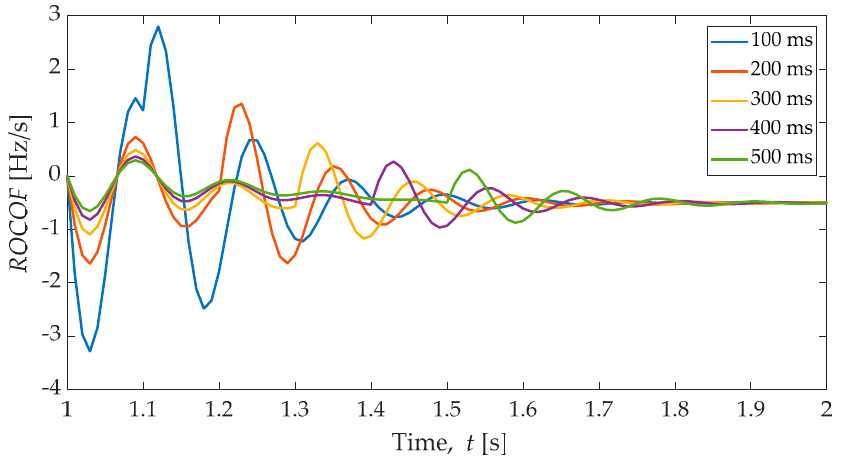
Figure 17. Rate of change of frequency ( ROCOF in Hz/s) calculated using moving window, five windows sizes are considered (100 ms to 500 ms).